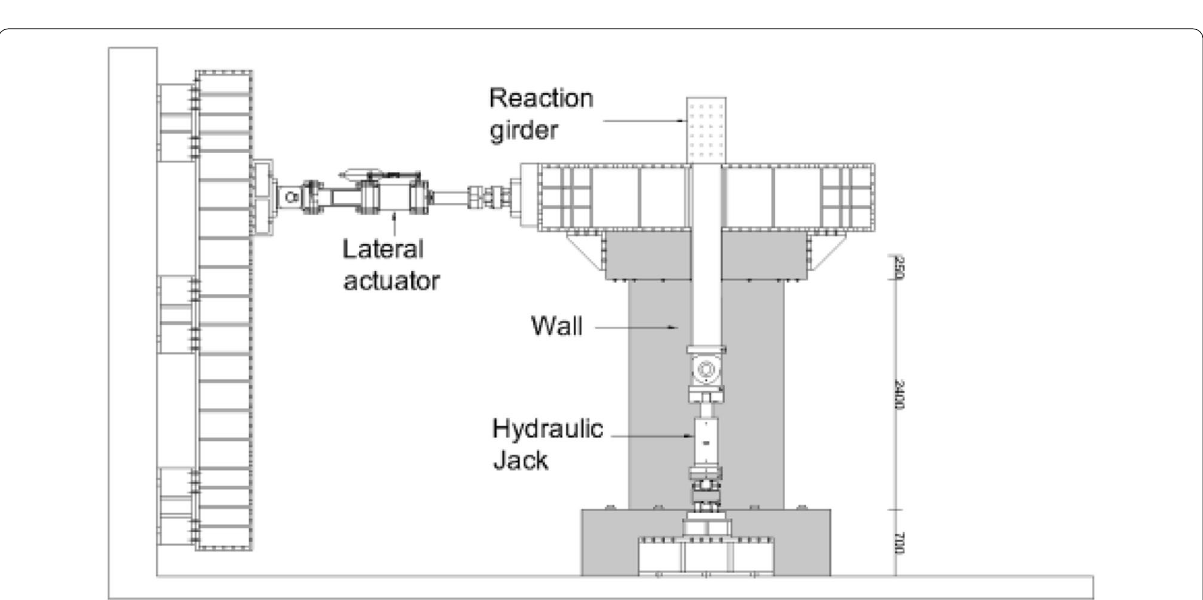
Fig. 4 Set-up for cyclic loading test (Unit: